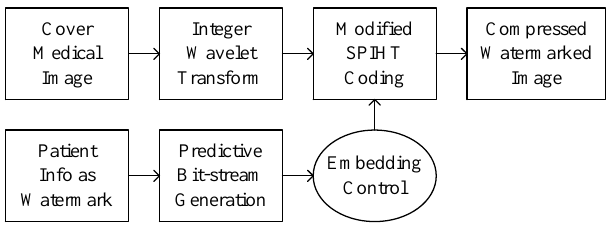
Fig. 2. The flow chart of the proposed watermark embedding process